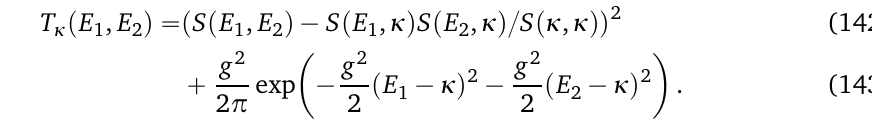
The subleading corrections to (141) correspond with having multiple extra